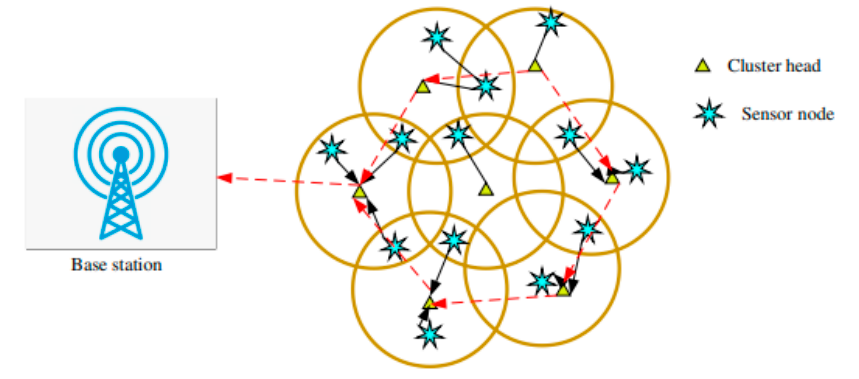
Figure 2. Network model of WSN-IoT.